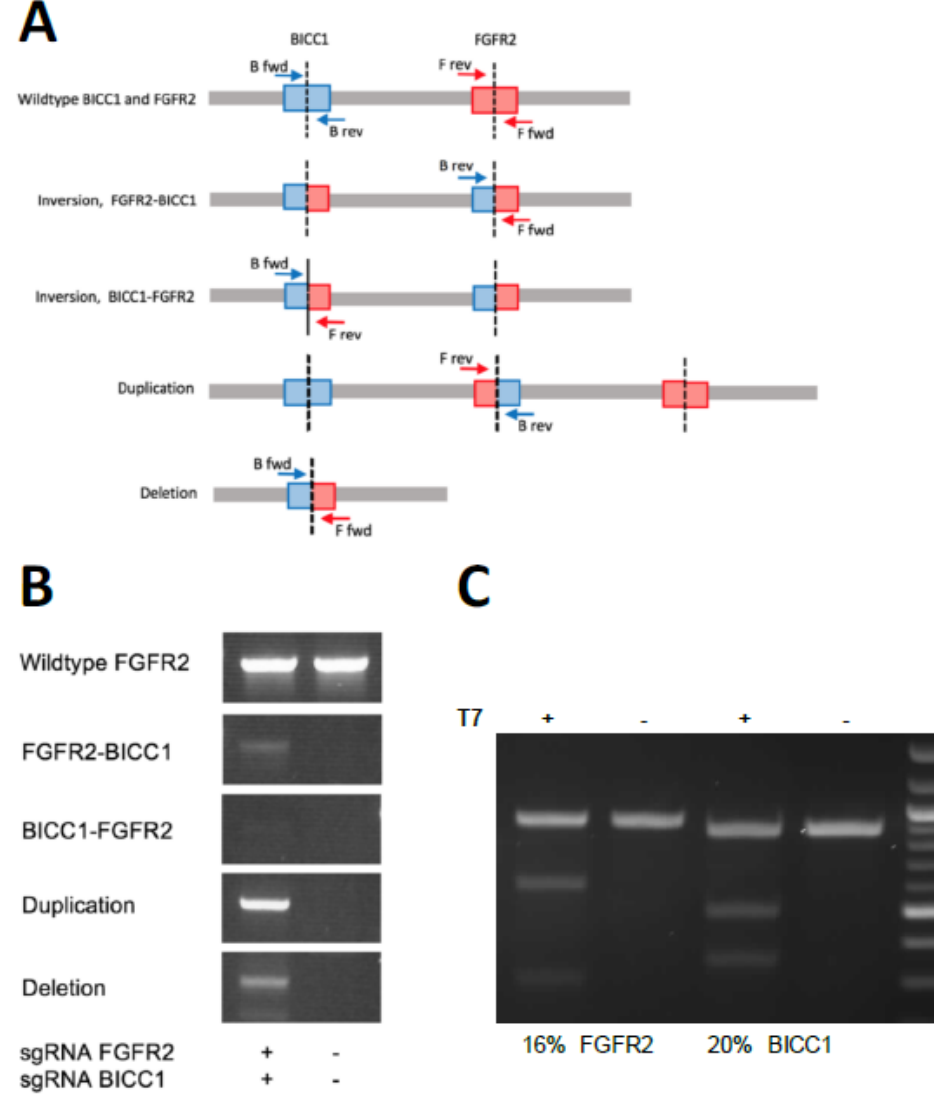
Figure 3. Detection of distinct genomic outcomes from sgRNA cutting. ( A ) Schematic of possible genomic outcomes of dual sgRNA cutting. ( B ) Detection of different genomic rearrangements in cells transfected with the two-plasmid system. ( C ) CRISPR editing efficiency after FACS sorting, as determined by T7 endonuclease assay. The indel frequencies are indicated below.